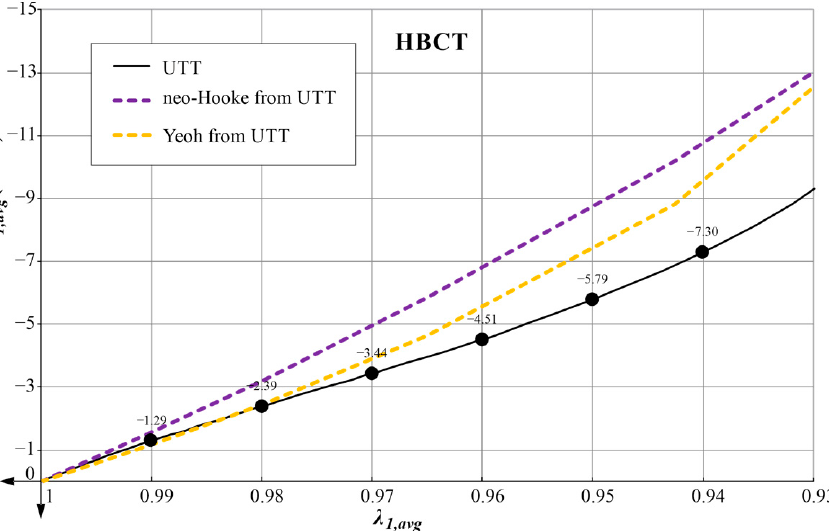
Figure 6. The response of high bearing, with the neo ‐ Hookean and Yeoh model of rubber for material parameters determined on the basis of the UTT.